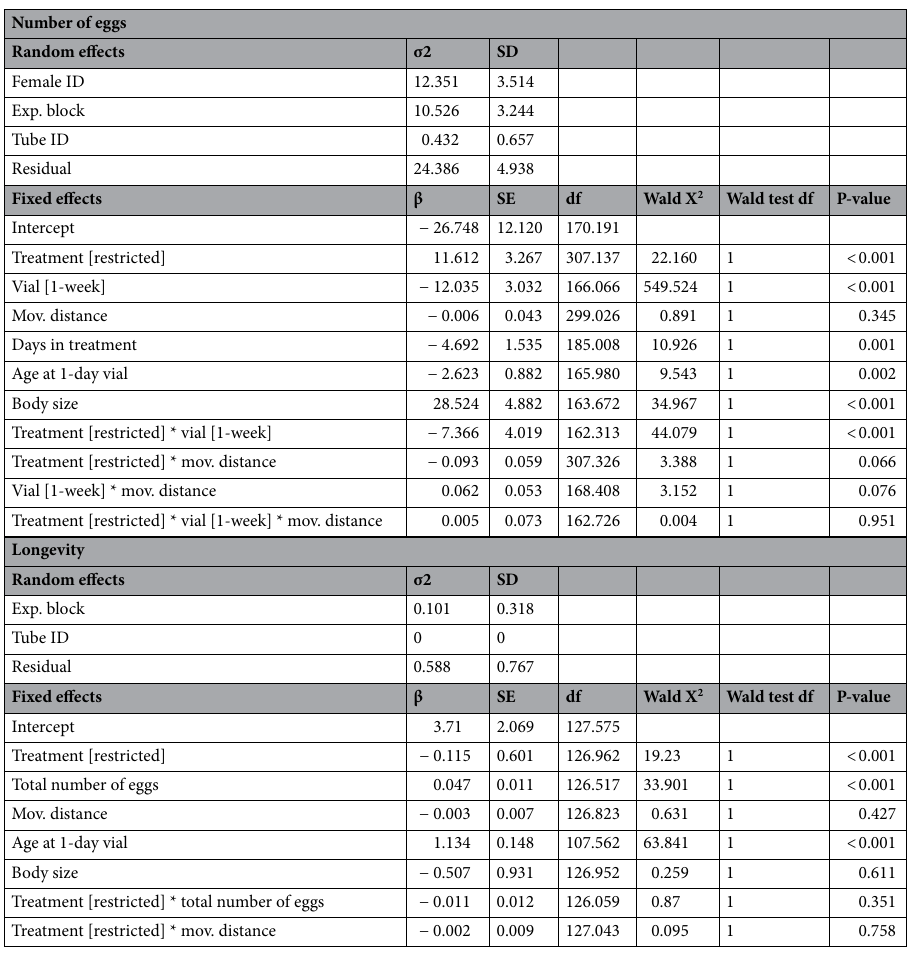
Table 4. Long-term experiment: results of linear mixed models testing the treatment effects of limiting resources in early life on subsequent life history decisions: number of eggs (on 1-day vial and 1-week